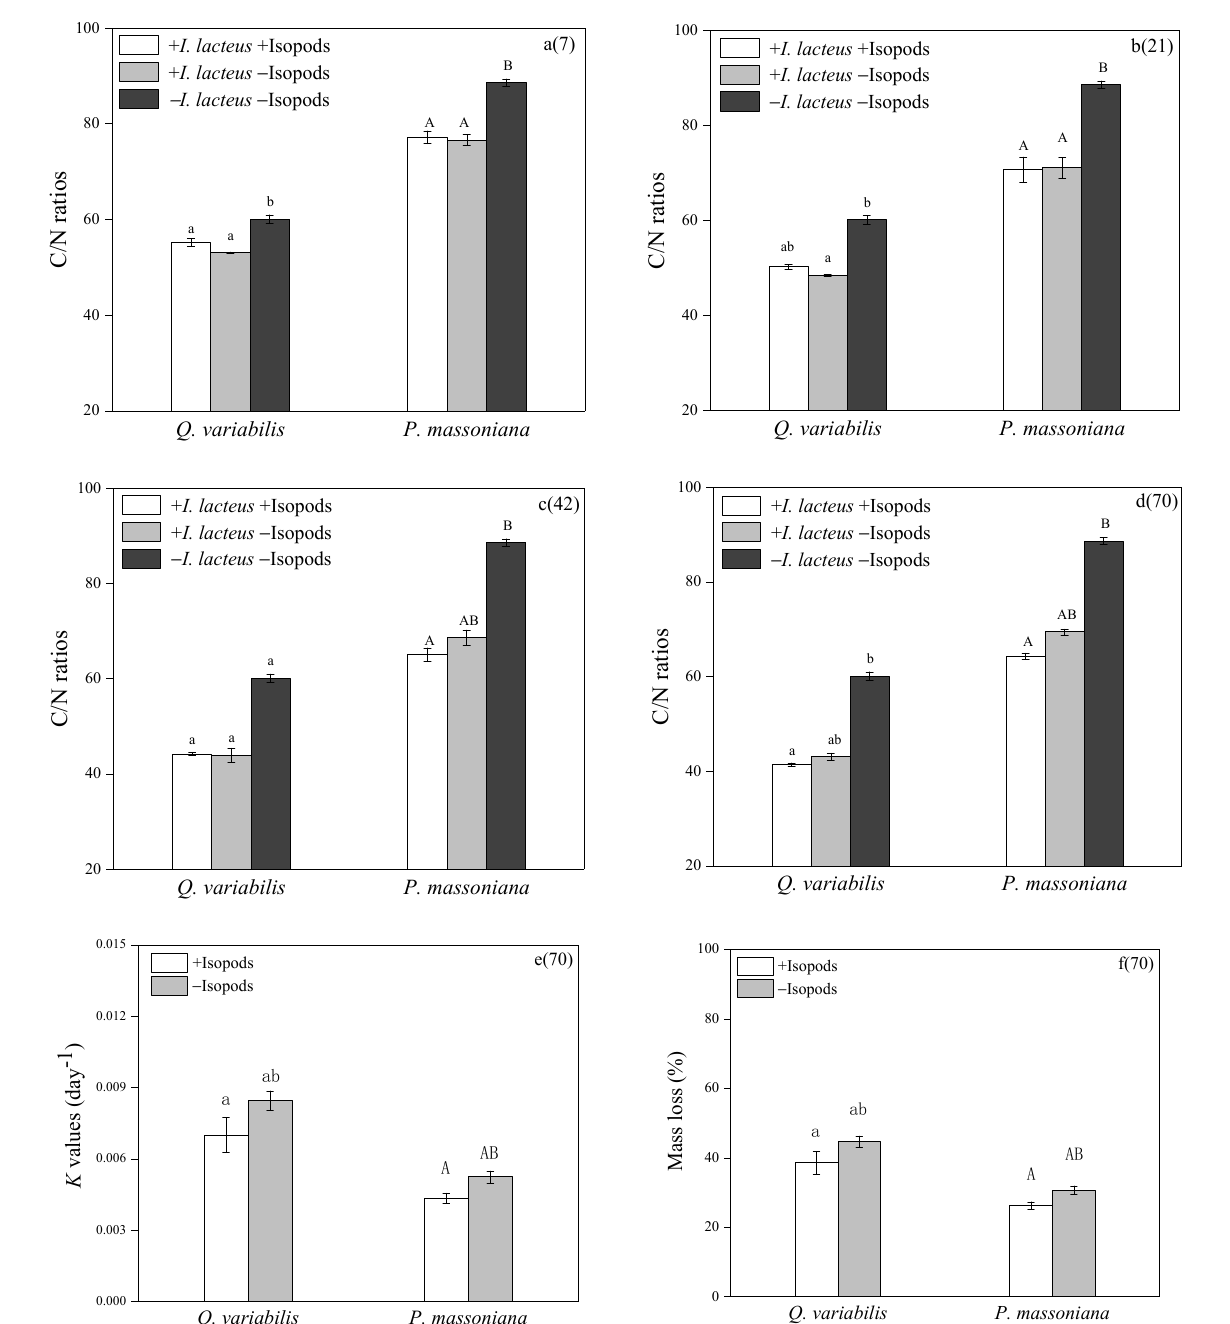
Figure 6. Physiochemical properties of Q. variabilis and P. massoniana on 7 days ( a ), 21 days ( b ), 42 days ( c ), 70 days ( d ), decomposition rates (mean k value, day − 1 ) ( e ) and mass loss ( f ) of the two leaf litters during 70 days of